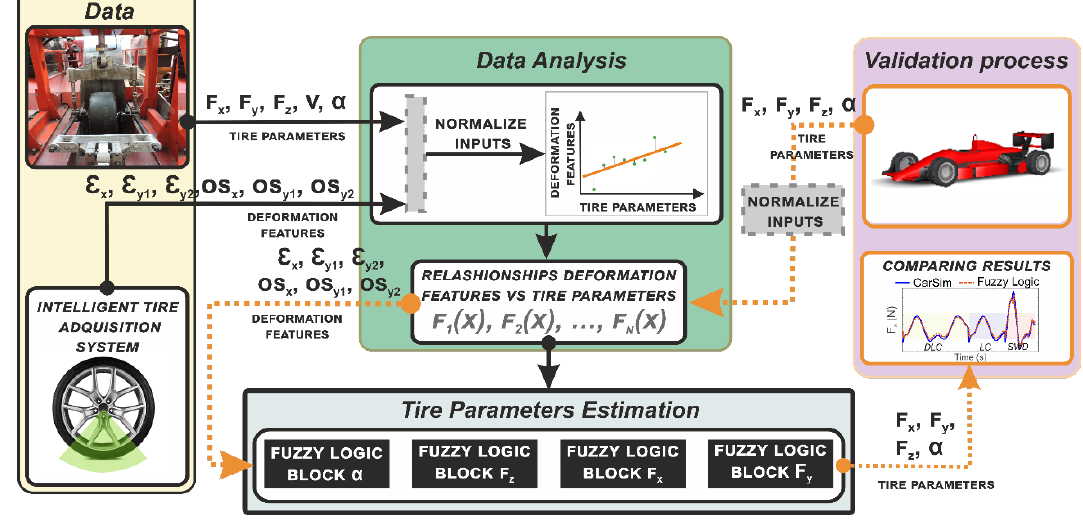
Figure 5. Working scheme used to develop the strain-based method.